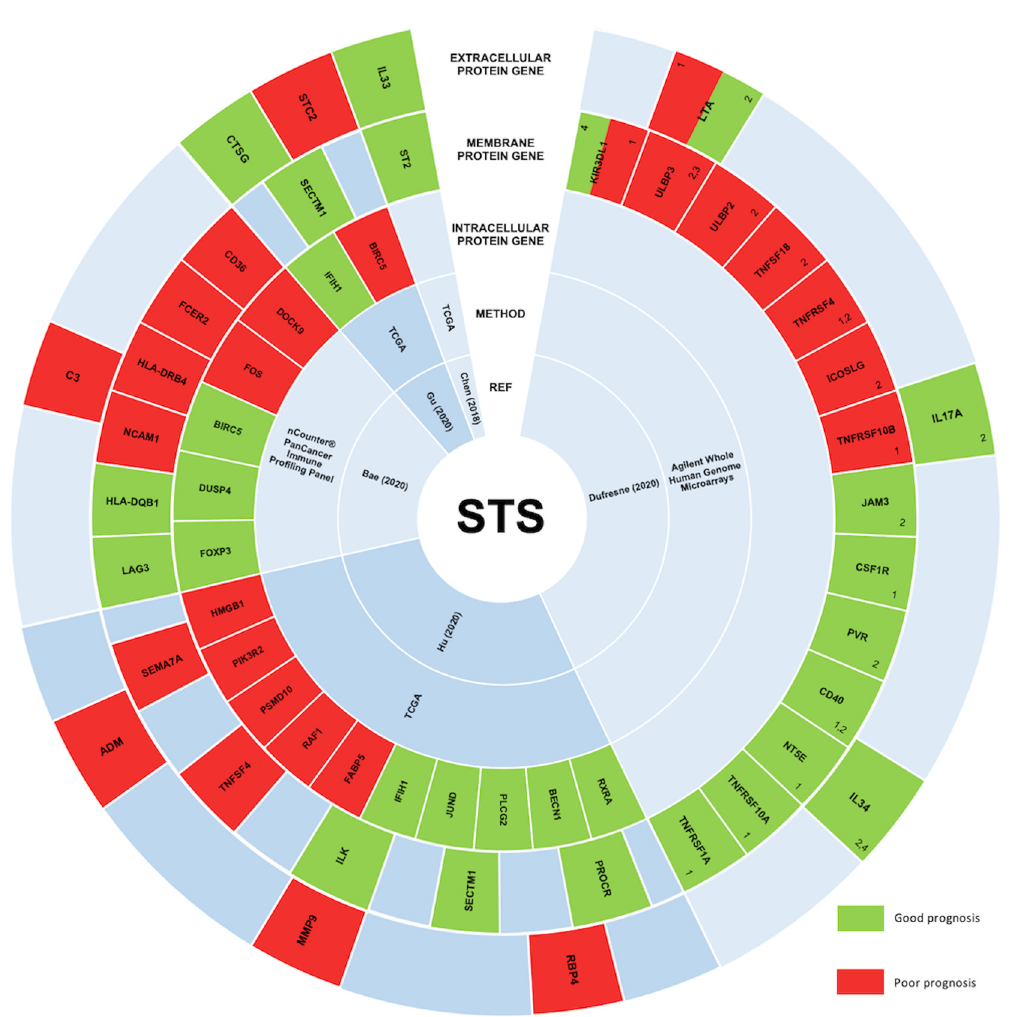
Figure 3. STS studies correlating the expression levels of immune-related genes and their prognostic significance. In STS, the expression of immune-related genes remains underexplored, and consequently, the prognostic value of these genes is still unclear. However, five main studies aimed at understanding this correlation, and their results are represented in this figure. Immune-related genes correlated with a good prognosis in STS are represented in green. On the other hand, immune-related genes associated with a bad prognosis are represented in red. From the peripheral to the center, circles represent genes encoding extracellular proteins, genes encoding transmembrane proteins, genes encoding intracellular proteins, the method used, and the respective study’s first author and publication year [99–103]. 1 Prognostic value